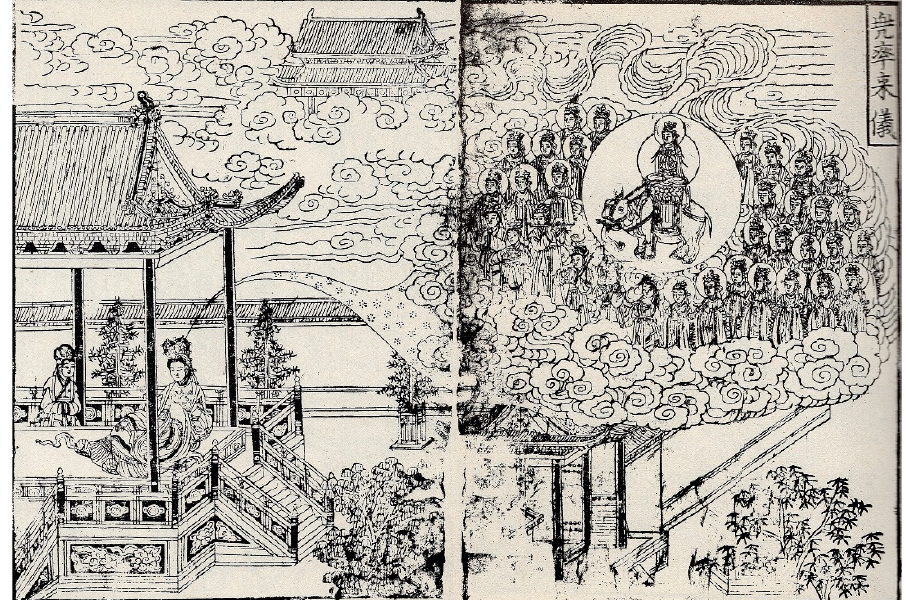
Figure 15. First woodblock print (Maya’s birth dream and conception) of the eight scenes of Buddha’s life from Episodes from the Life of Sakyamuni Buddha (Weorin seokbo), Joseon dynasty (1459), 21.7 × 32.2 cm, Seogang University Library (Humanities Research Institute Sogang University 1972, pp. 31–32).